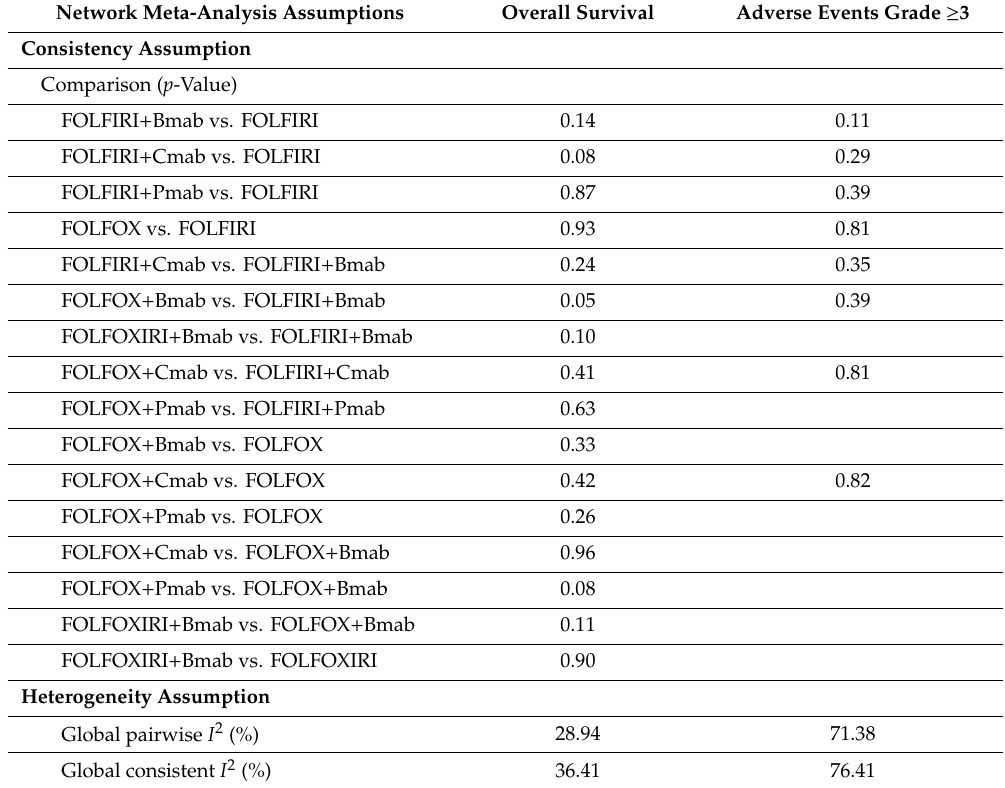
Table 4. Assumption checking of consistency and